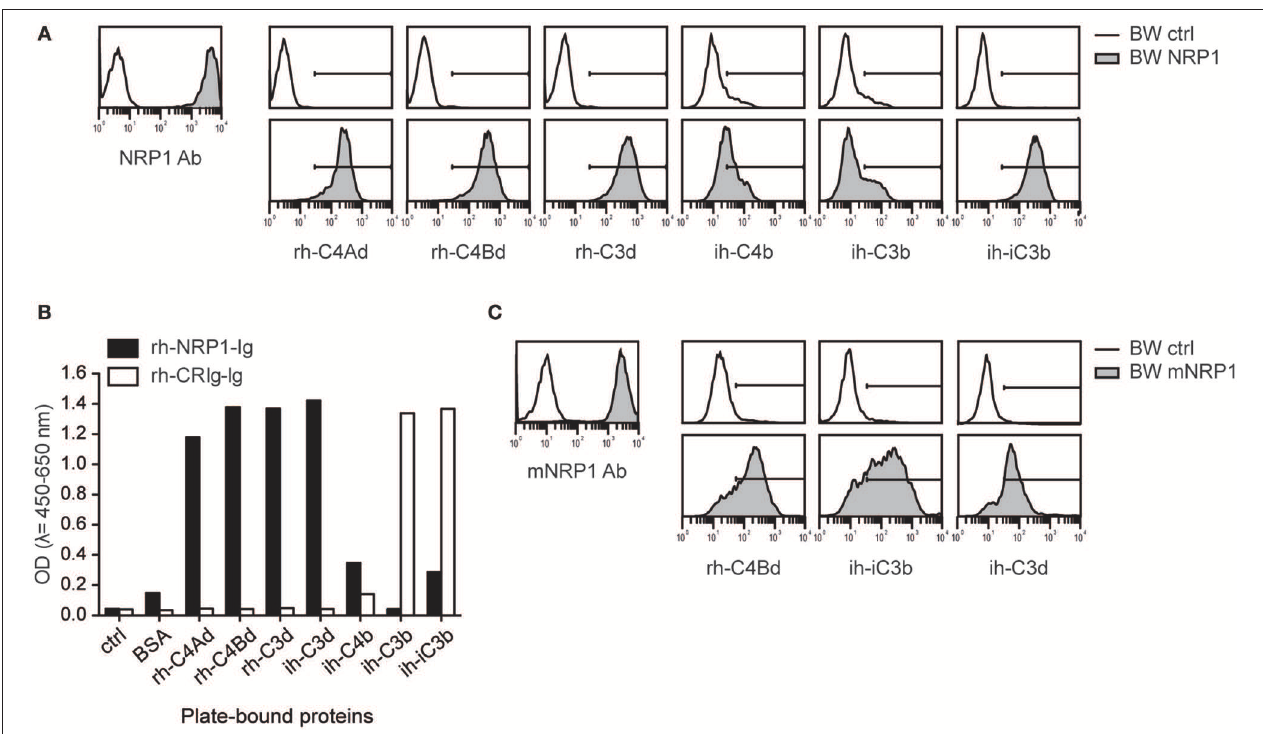
FIGURE 2 | Interaction of NRP1 and mNRP1 with complement split products C4d, C3d, and iC3b. (A) Flow cytometric analysis of BW cells transduced to express high levels of human NRP1. Interaction of indicated CSPs (20 µ g/ml each) with BW control cells (open histograms) and BW cells expressing NRP1 (gray histograms). Expression of NRP1 was verified with a monoclonal NRP1 antibody. (B) Interaction of plate-bound CSPs (465nM each) with soluble recombinant human NRP1-immunoglobulin fusion protein (rh-NRP1-Ig) and complement receptor Ig fusion protein (rh-CRIg-Ig) analyzed in an ELISA-based assay. (C) Binding of murine NRP1 (mNRP1) mAb and recombinant human CSPs (rh-C4d, ih-iC3b, and ih-C3d) to BW control cells (open histograms) and BW cells expressing mNRP1 (gray histograms). Data shown is representative of two independently performed